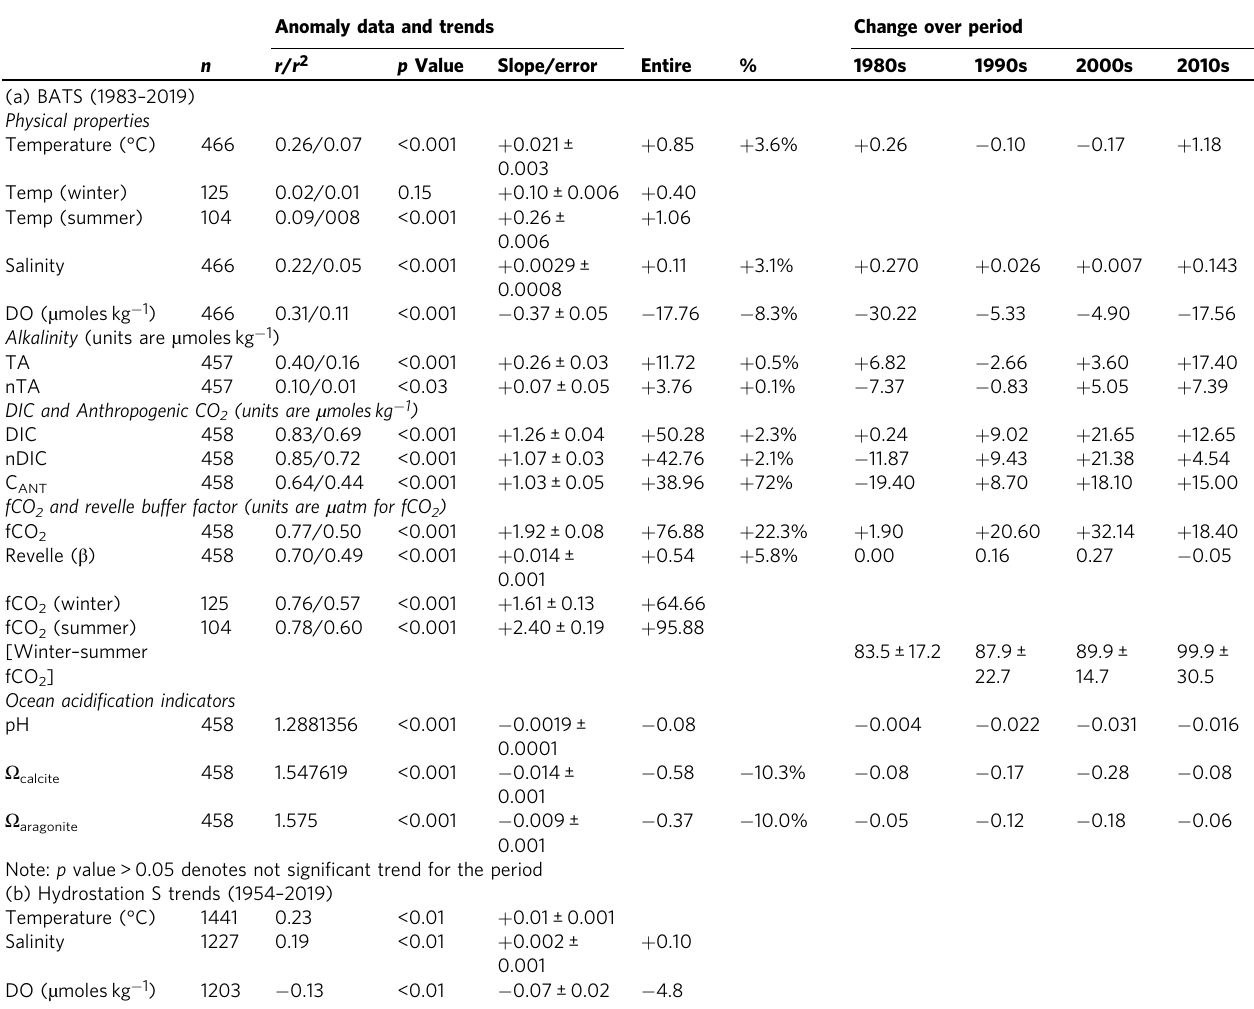
Table 1 Trend analysis of physical properties, seawater CO 2 – carbonate chemistry, and ocean acidi fi cation indicators at the BATS-Hydrostation S site from 1983 to